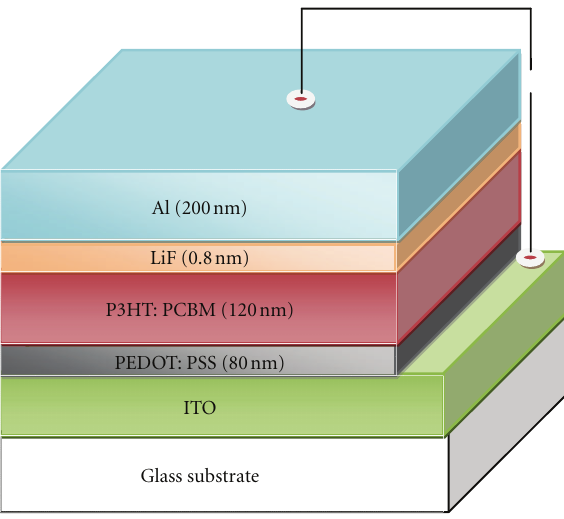
Figure 1: Schematic diagram of solar cell device.